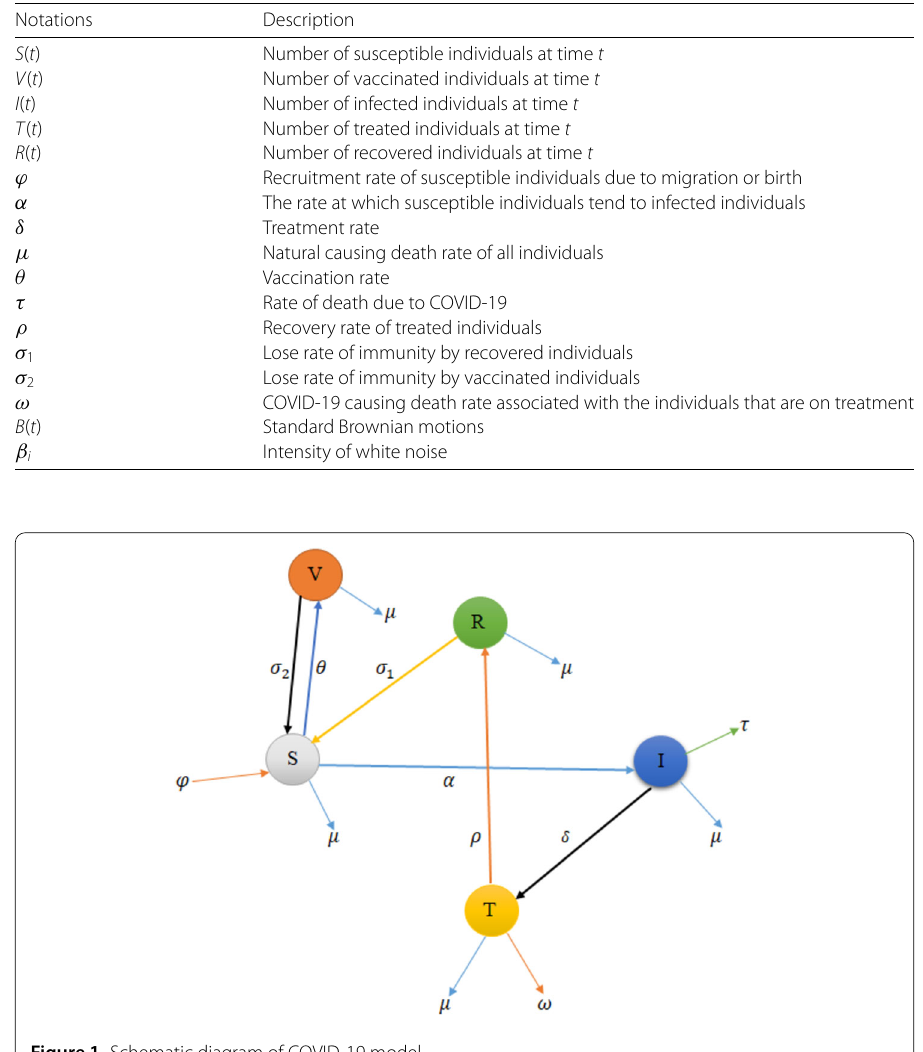
Incorporating the intensity of stochastic environmental factors β I and Brownian motion B I ( t ) into the SVITR deterministic model Eq. (2.1), we get the corresponding stochastic model of COVID-19: